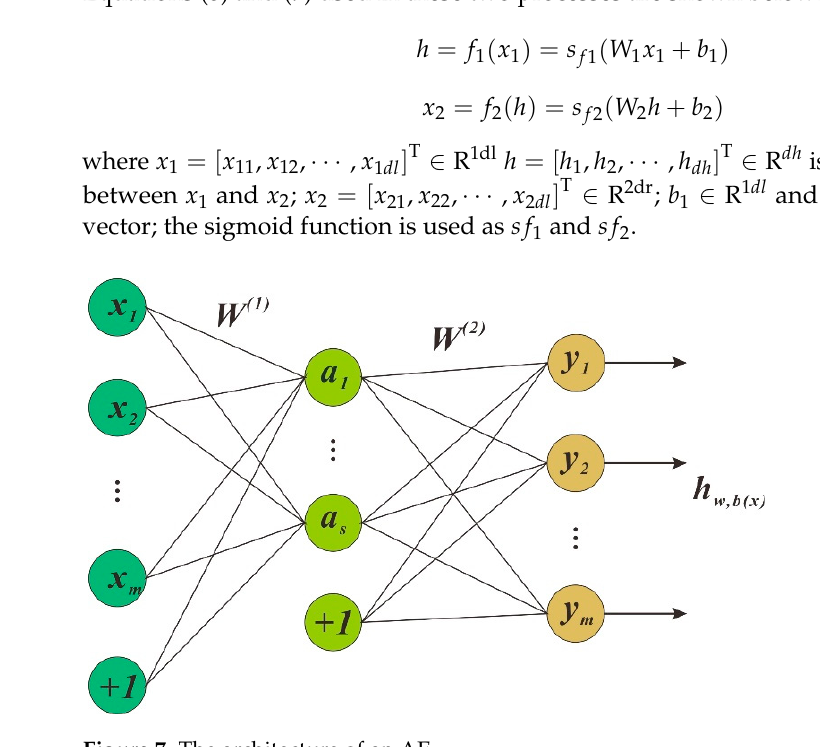
Figure 7. The architecture of an AE.